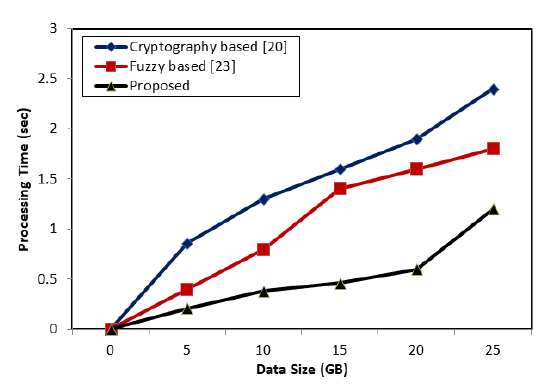
Figure 6. Processing time during integrity verification